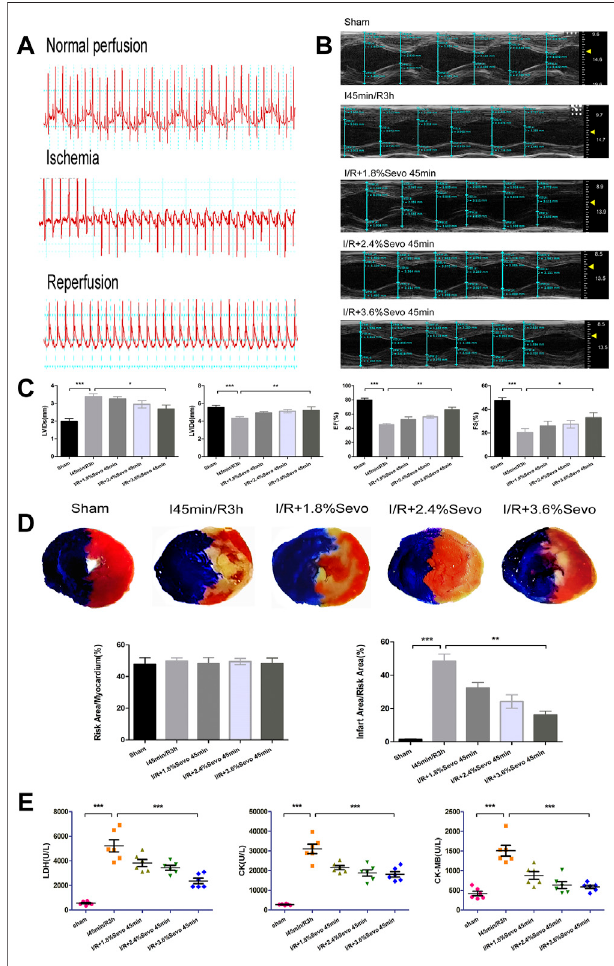
FIGURE 3 | Sevo fl urane alleviates MIRI in rats. (A) Typical electrocardiogram of normal perfusion, ligation of LAD and reperfusion. (B) Cardiac ultrasonography in rats of normal perfusion, MIRI and treatment with different concentrations of sevo fl urane. (C) Histogram of rat cardiac ultrasonography. (D) Myocardial infarction area and histogram of rats treated with different concentrations of sevo fl urane. (E) Effects of Sevo fl urane at different concentrations on the release of LDH, CK, and CK-MB in myocardial tissueafter MIRI.Dataareexpressed relative tothemeanvalueofsham group and were presented as mean ± SD (n = 6). * p < 0.05, ** p < 0.01, *** p < 0.001 vs. respective